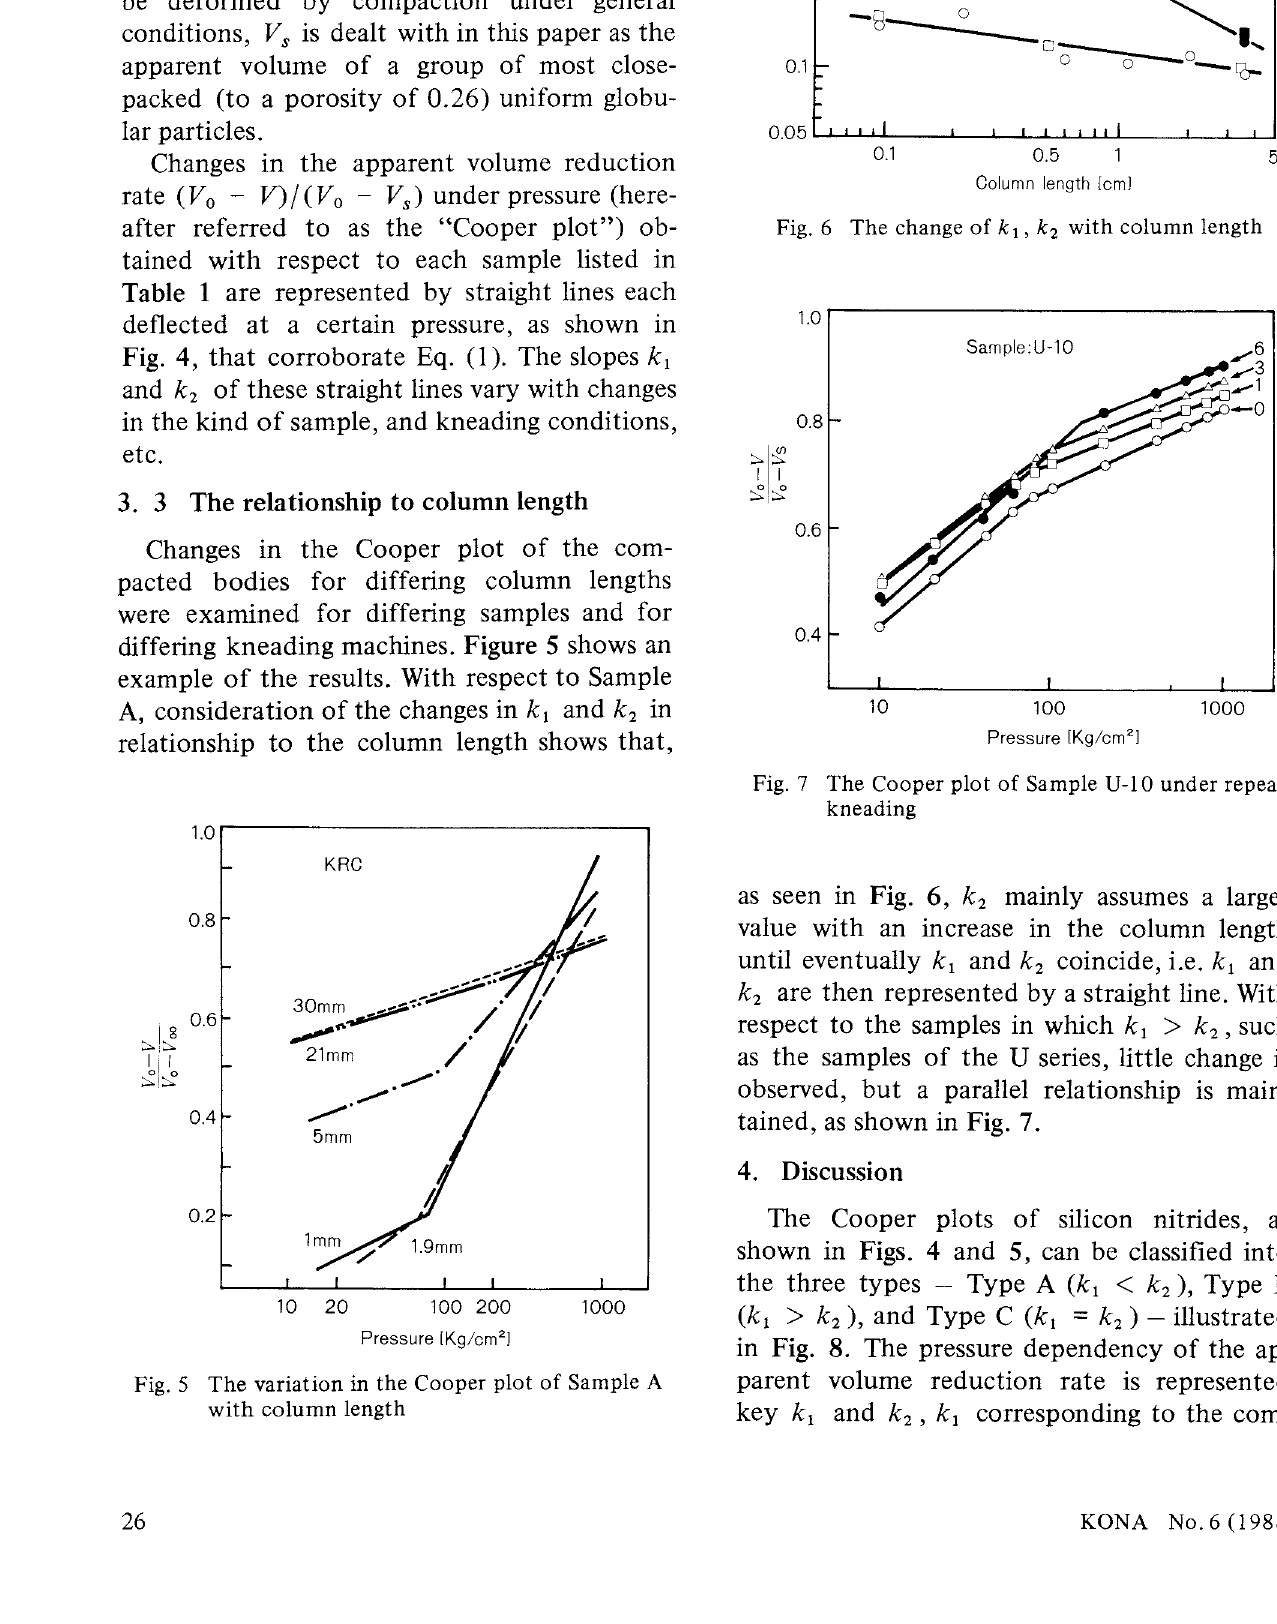
k 2 with column length 1 ,